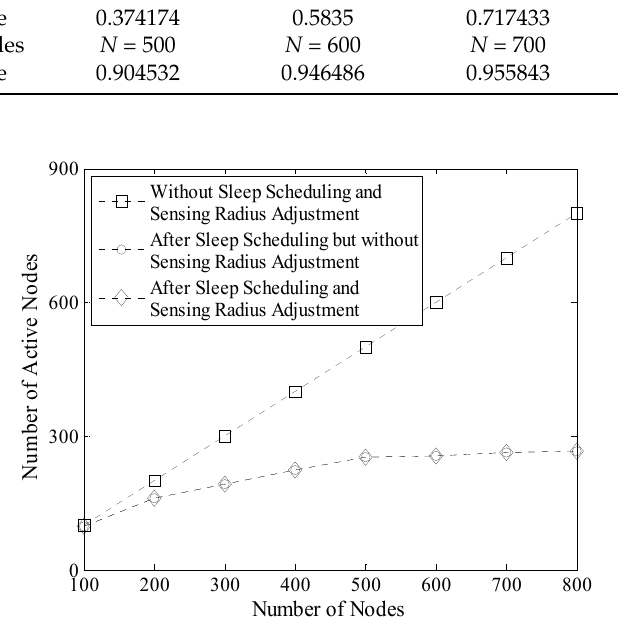
Figure 15. Number of active nodes in LDGM (100 m × 100 m).